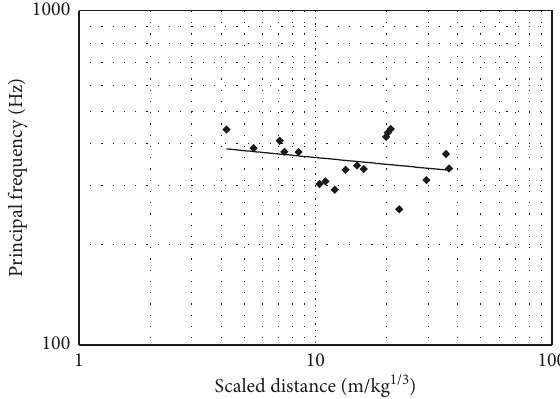
Figure 6: PF for single-hole blasting versus scaled distance.